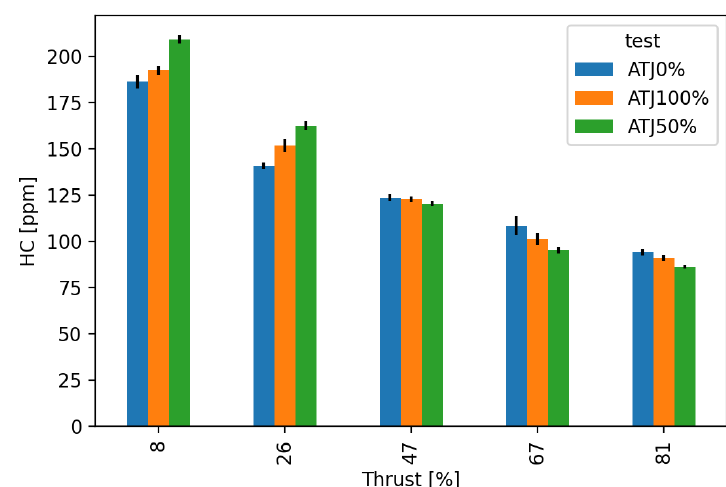
Figure 14. GTM-140/ATJ: CO 2 emission. Figure 15. GTM-140/ATJ: HC emission. Figure 15. GTM-140/ATJ: HC emission.